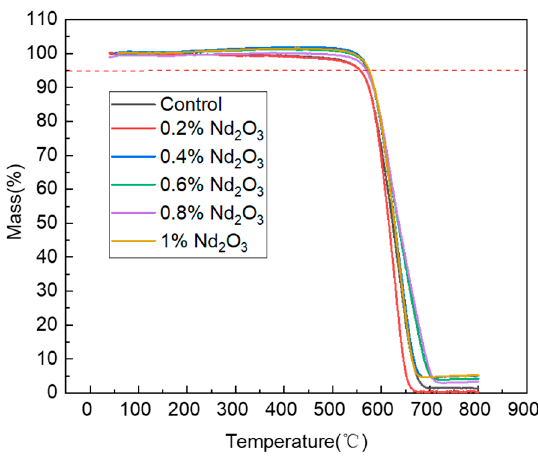
Figure 8. The TGA curves of the polyimides with different Nd 2 O 3 contents. Table 1. The TGA database of the polyimide with different Nd 2 O 3 contents (Td5%, Td10%).